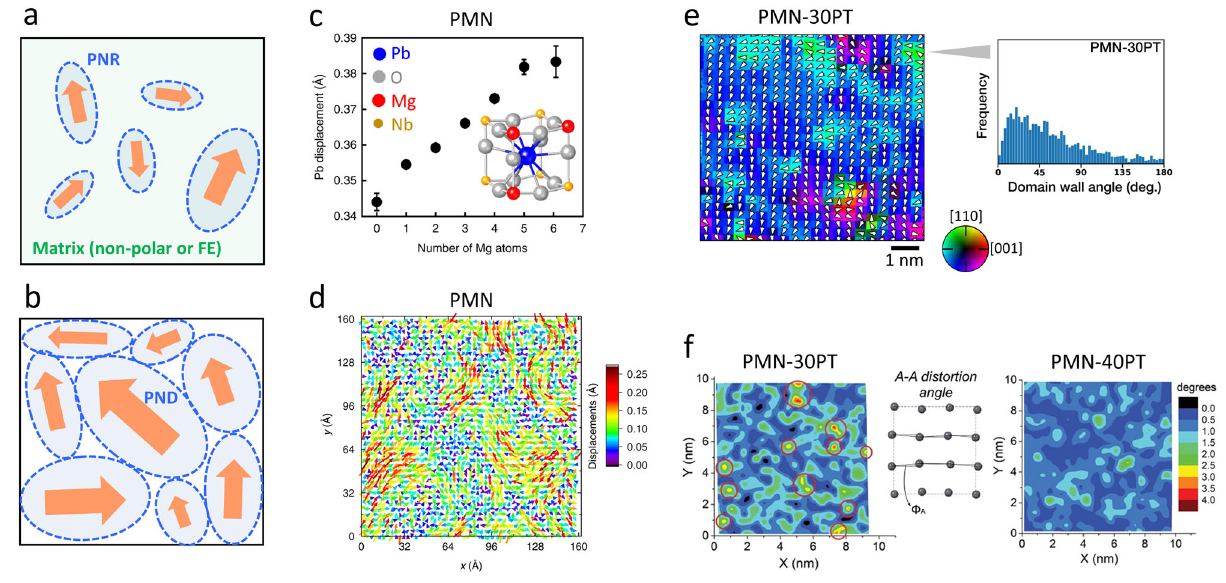
Fig. 2 Polar structure of PMN – PT. a Representations of two different microscopic polar states of RE-based materials consisting of ( a ) polar nanoregions (PNRs) embedded into a non-polar or ferroelectric (FE) matrix and ( b ) polar nanodomains (PNDs) separated by low-angle domain walls. The latter schematic was reproduced based on the study by Takenaka et al. 25 on PMN-PT and Eremenko et al. 26 on PMN; note that both these studies adopted combined theoretical and experimental approaches. c Correlation between Pb displacements from the center of the PbO 12 cage (see inset) and number of surrounding B-site Mg ions in PMN; d projected Pb displacement map for PMN with arrows and colors indicating the direction and magnitude of the displacements, respectively. The data shown in ( c , d ) were extracted using reverse Monte Carlo simulations as reported by Eremenko et al. 26 . To be noted is that this method reported in Ref. 26 is based on PMN structural modelling by performing simultaneous re fi nements using a wide range of experimental dataset, including Neutron and X-ray powder total-scattering, extended X-ray absorption fi ne structure, 3D X-ray single-crystal diffuse-intensity distributions and Neutron Bragg pro fi les. e Projected polarization map of a region in PMN single crystal with 30 mol% PT (PMN – 30PT) as determined from the difference of the center-of-mass positions of cations and anions using scanning transmission electron microscopy (STEM) analysis (see Kumar et al. 37 ). The direction and magnitude of the off-centric displacements is indicated by the different colors and color brightness, respectively. The inset shows the extracted statistical distribution of domain-wall angles, con fi rming the presence of a large fraction of low-angle domain walls (peak at ~20°). f Maps of Pb distortion angle Φ A (see inset) in PMN – 30PT and PMN – 40PT ceramics, illustrating the compositional dependence of the Pb positional disorder (original data are reported in Otonicar et al. 36 ). Figures shown in ( e ) were reprinted from Ref. 37 by permission from Springer